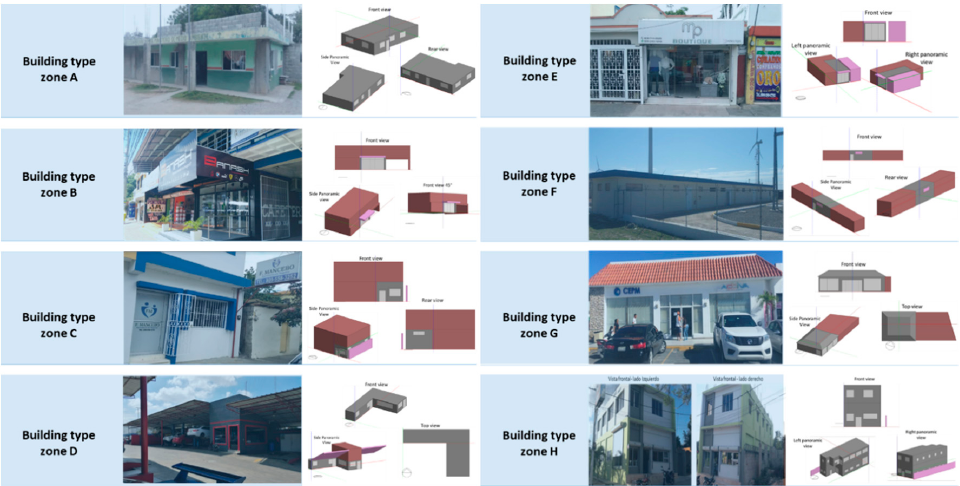
Figure 4. View of building types for each area of the case under study.